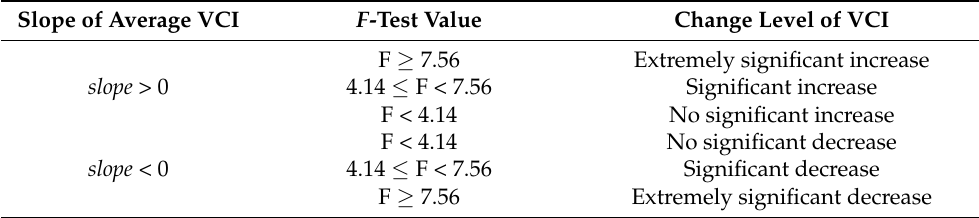
Table 1. Different change grades of VCI defined by trend analysis and F